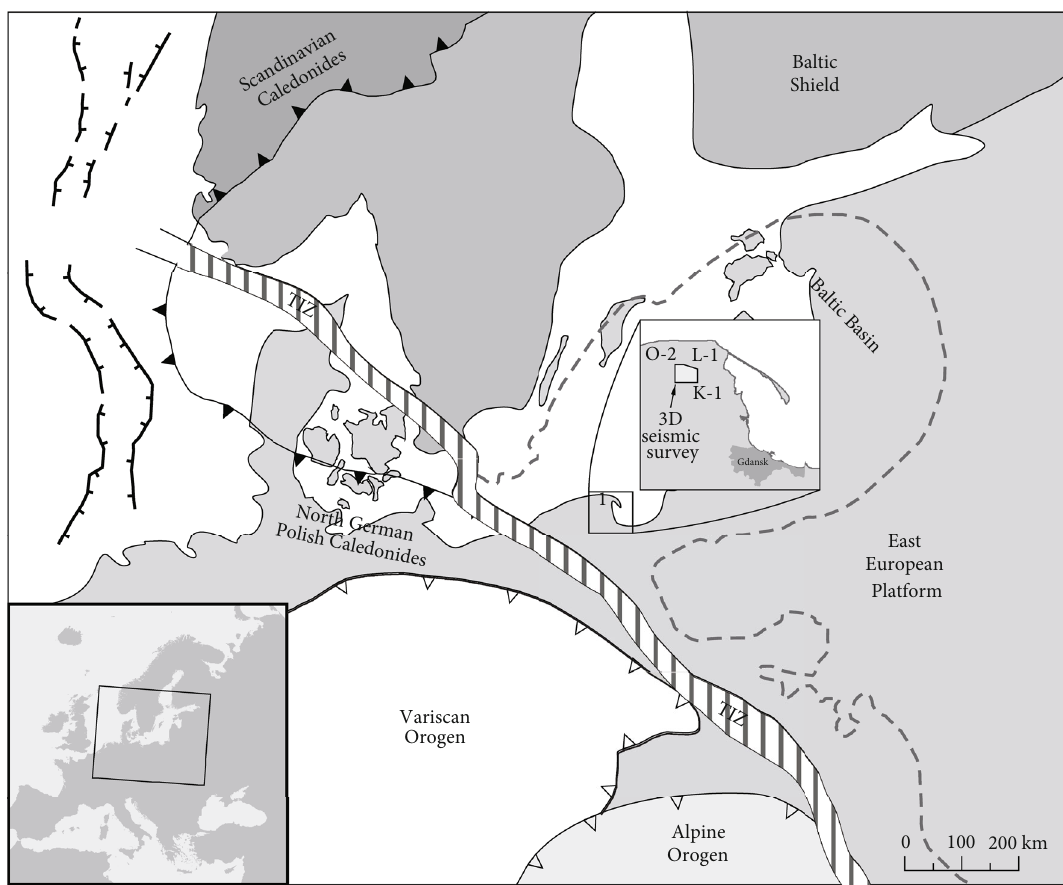
Figure 5: Location of the survey area within the main tectonic units of north-central Europe showing the Baltic Basin (dashed line). TTZ: Tornquist-Teisseyre Zone; O-2, L-1, and K-1 — wells location, after Poprawa et al.